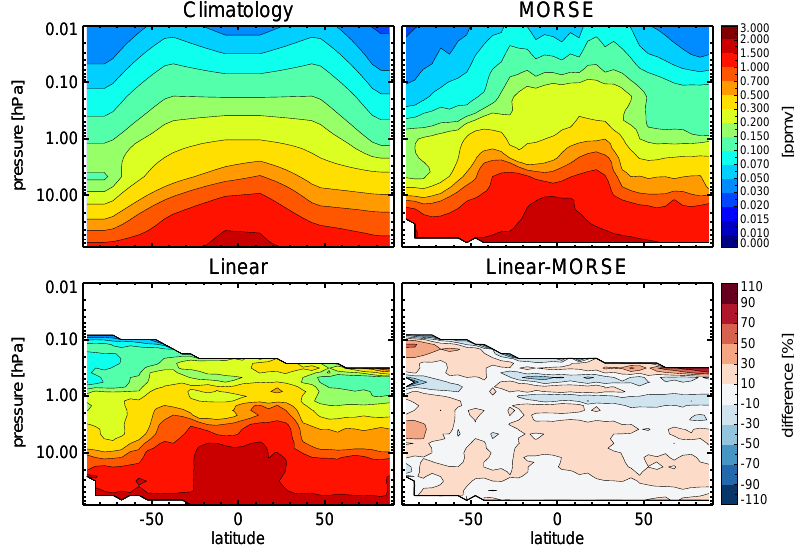
Fig. 19. CH 4 zonal mean for 7 June 2007 for climatology, MORSE and the MIPAS linear retrieval. The top row displays climatology and MORSE, while the bottom row displays the MIPAS linear retrieval results as well as the percentage difference between the two retrievals (linear − MORSE).